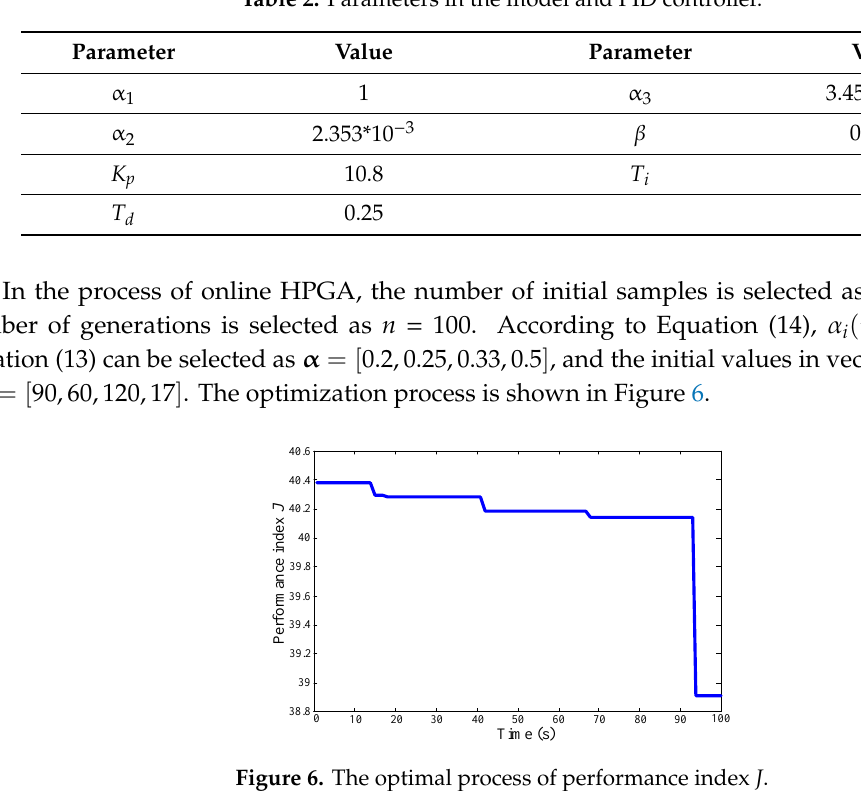
Table 3. Performance of the proposed method and PID controller.